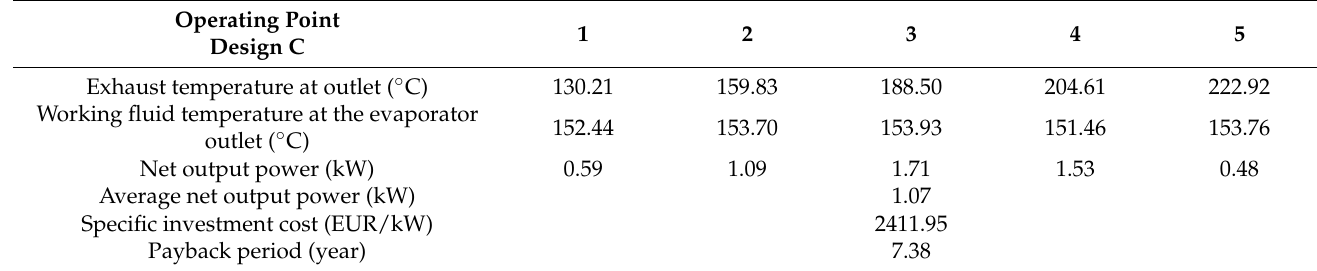
Table 15. Verification for Design C considering negative